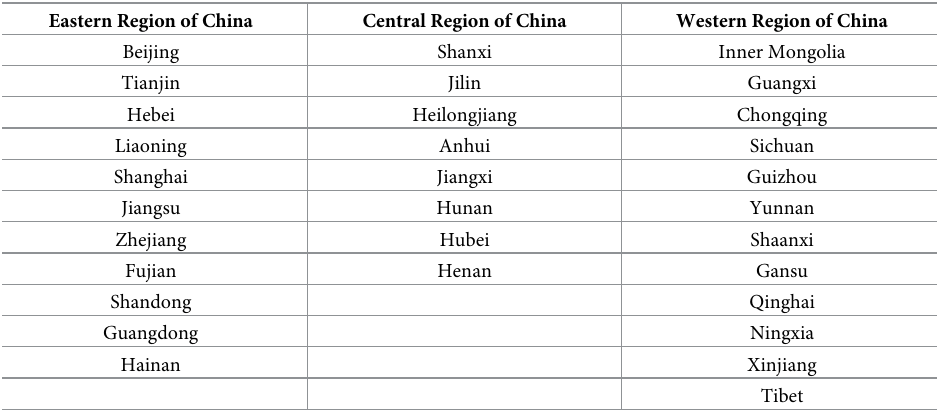
Table 2. Classification of 31 regions of China. Eastern Region of